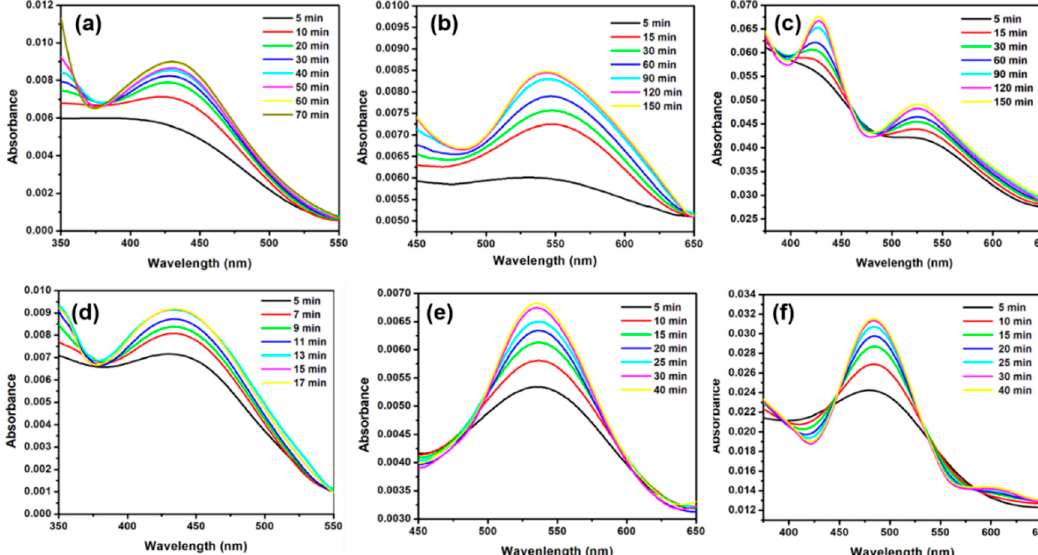
Figure 3. Kinetic analysis of the formation of Ag, Au, and Au–Ag bimetallic (phase separated/alloy) NPs prepared with different concentrations of PE. ( a ) Ag NPs, ( b ) Au NPs, and ( c ) Au–Ag NPs prepared using low concentrations of plant extract. ( d ) Ag, ( e ) Au, and ( f ) Au–Ag alloy NPs prepared using higher concentrations of plant extract.